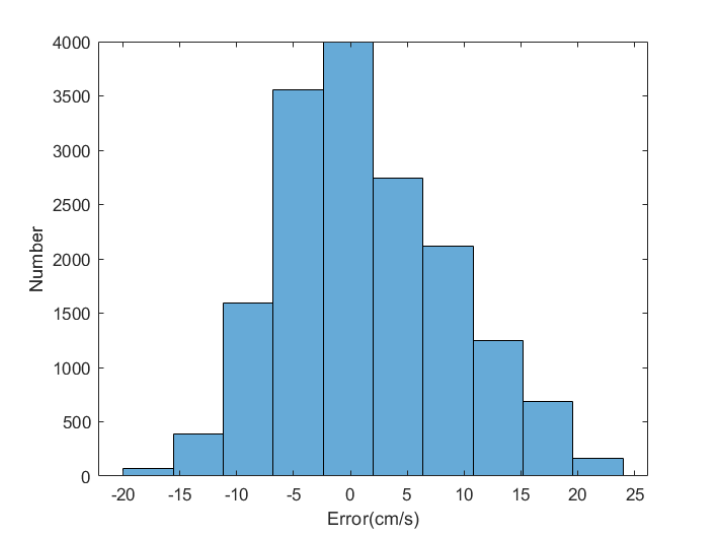
Figure 17. Statistical chart of the error distribution of the ocean current obtained by the two